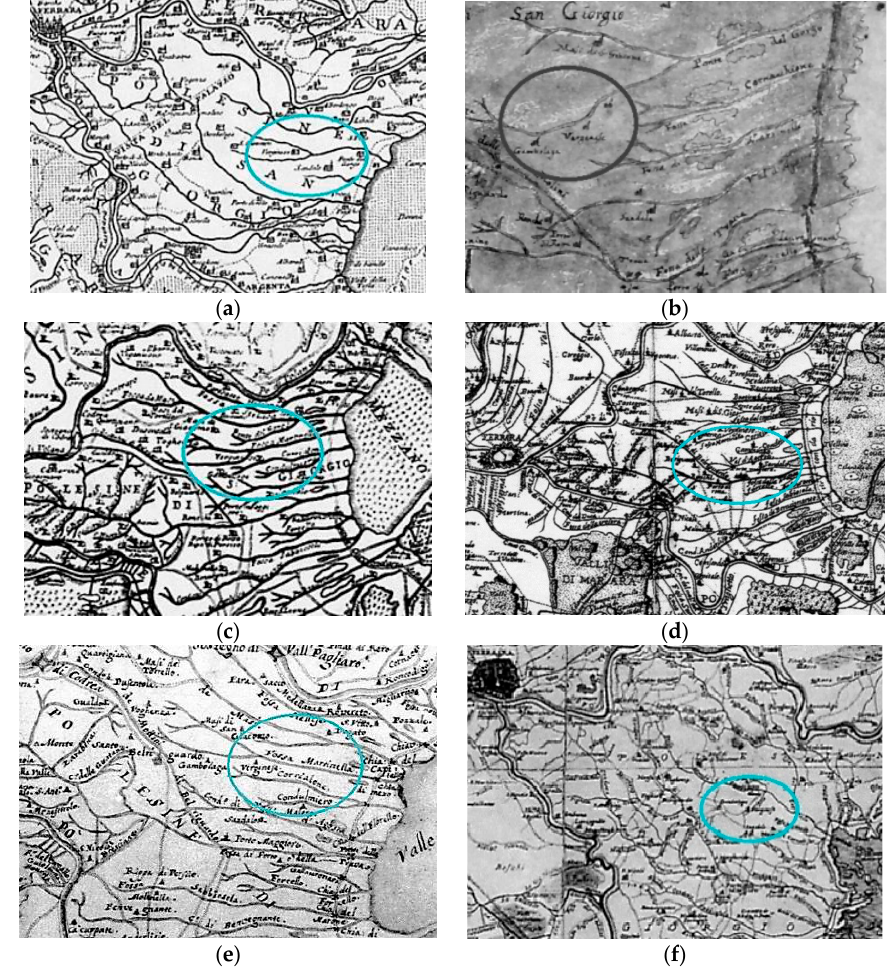
Figure 18. Extracted maps from ancient Ferrara cartography with attested rivers (North to the top) and, in the circle, the Po River with the course running close to Verginse Castle, Gambulaga: ( a ) Aleotti 1603; ( b ) Penna 1658; ( c ) De Rossi 1709; ( d ) Bonfadini 1709; ( e ) Facci 1716; ( f ) Baruffaldi 1758.